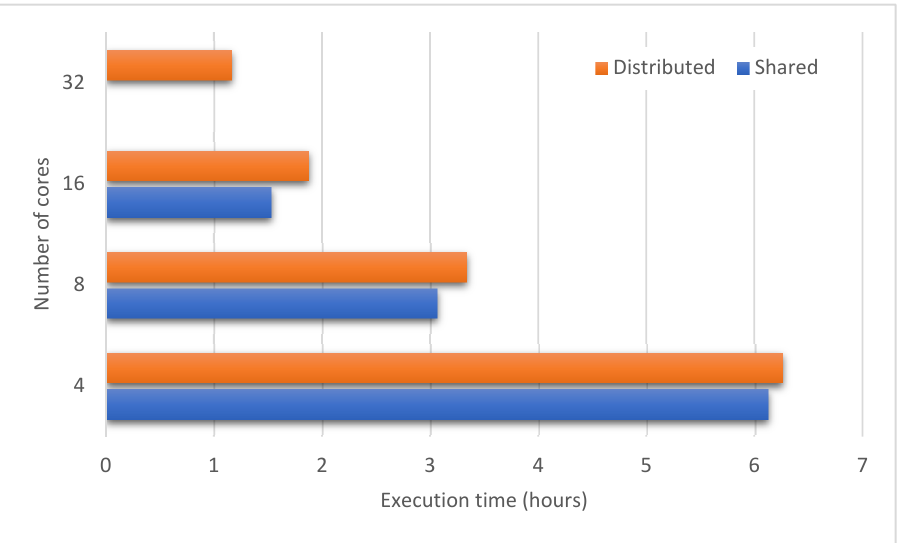
Figure 6. Execution time of the distributed and shared configurations when the number of CPU cores varies.